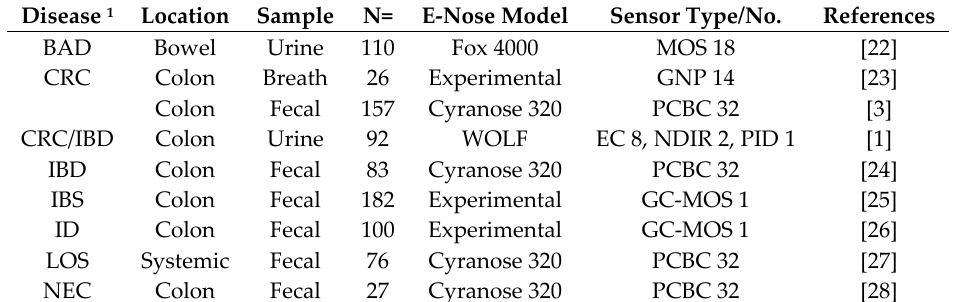
Table 1. Recent applications of electronic-nose technologies for the noninvasive early diagnosis of gastrointestinal